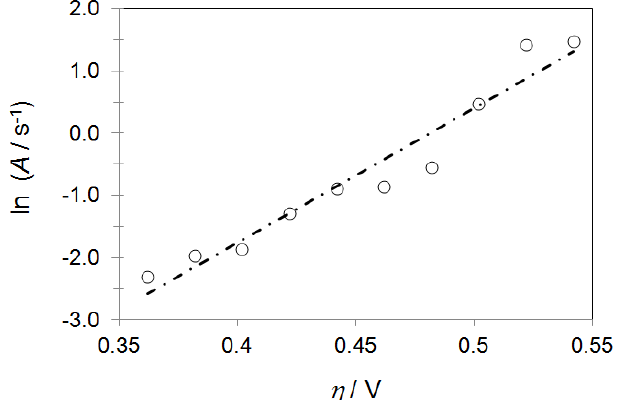
Figure 9. ln A vs. η plot, used to calculate the critical nuclei’s size according to Eq. 17 . The broken straight line corresponds to the linear fit to the experimental